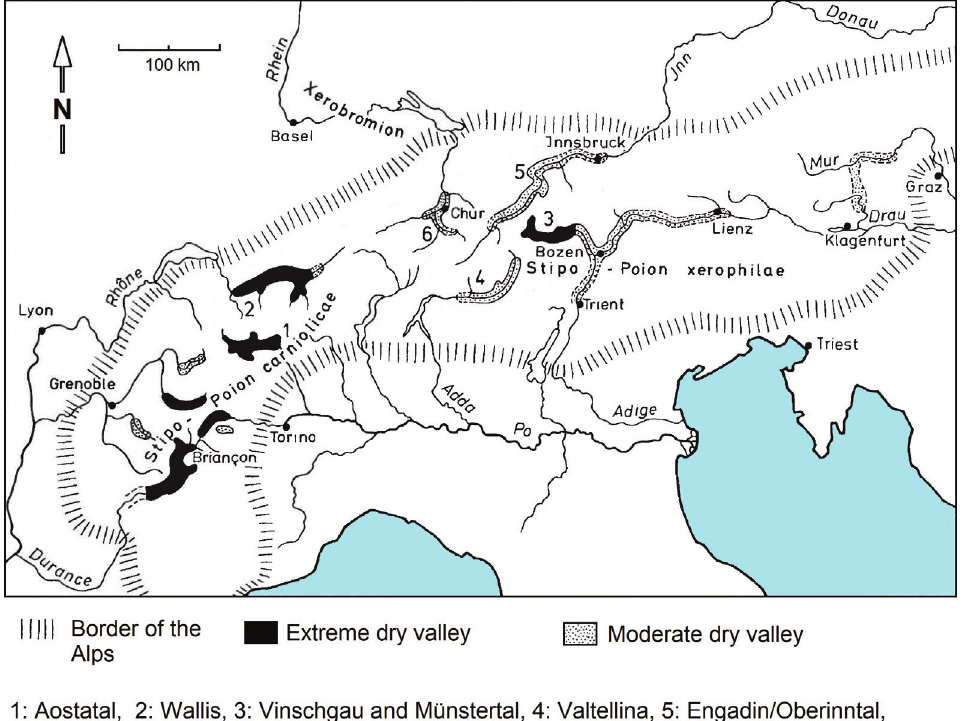
Figure 1. Distribution of the inner-alpine dry valleys (with friendly permission by Angelika Schwabe-Kratochwil, ac- cording to Braun-Blanquet (1961), modified by M. Lübben) and the two alliances ( Stipo-Poion carniolicae and Sti- po-Poion xerophilae ) described by Braun-Blanquet (1961, see also Mucina et al. 2016).